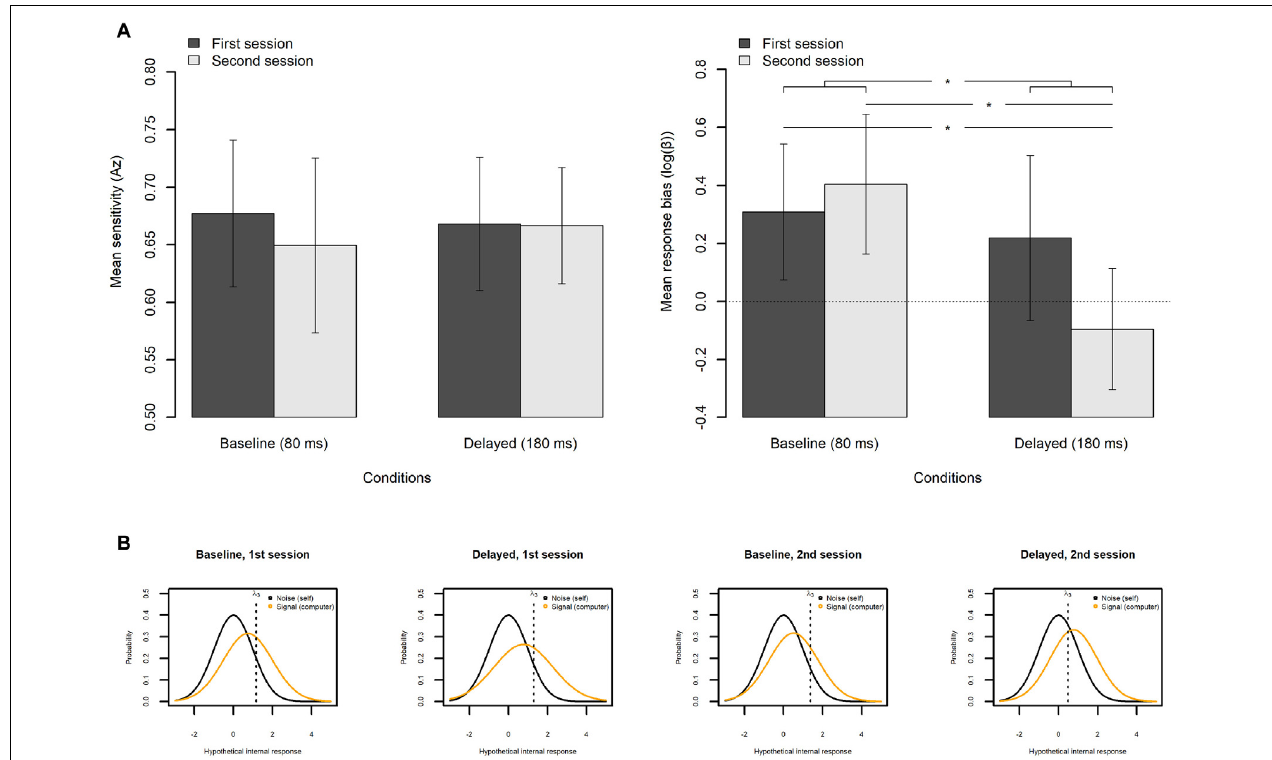
FIGURE 10 | Results from the signal detection theory (SDT) analysis on the agency judgment (AJ) data. (A) Mean sensitivity ( Az ) and response bias ( β ) of the AJ in each condition in each session. The error bar represents a 95% confidence interval of the mean. * p < 0.05. (B) Estimated response probability function within the SDT framework. Median was used as a representative value of each